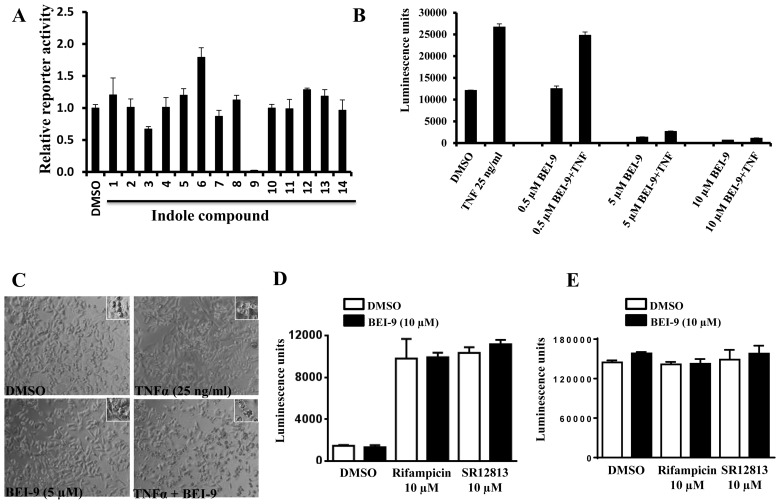
BEI-9 suppresses basal and induced NF-κB activation. (A) SW480 cells engineered to report intracellular activation of NF-κB signaling pathway were exposed to dimethyl sulfoxide (DMSO) or with each of the 14 indole compounds. Basal reporter activity, measured relative to DMSO-treated cells is shown. (B) Reporter activity in SW480 NF-κB reporter cells was induced by treating the cells with 25 ng/ml of TNFα. The effects of DMSO and BEI-9 (0.5, 5, or 10 µM) on TNFα-induced NF-κB reporter activation were measured and plotted as luminescence units. (C) Morphology of SW480 cells exposed to DMSO, TNFα (25 ng/ml), BEI-9 (5 µM), or a combination of TNFα and BEI-9. (d) hepg2 cells were transiently transfected with human pregnane X receptor (hPXR) and luciferase-linked PXR target reporter CyP3a4-luc. At 24 h after transfection, the cells were exposed to DMSO or human PXR agonists (rifampicin or SR12813) for 20 h. BEI-9 (10 µM) or the vehicle control (DMSO) was added to the cells 5 min prior to measuring the luciferase activity using the Neolite Luciferase reporter gene assay. BEI-9 did not directly inhibit the activity of the luciferase enzyme in reporter assays. (E) Cells were similarly treated as in C. DMSO or BEI-9 was added to the cells 5 min prior to measuring cell viability using the CellTiter-Glo Luminescent Cell Viability assay, which measures ATP availability in the cells.